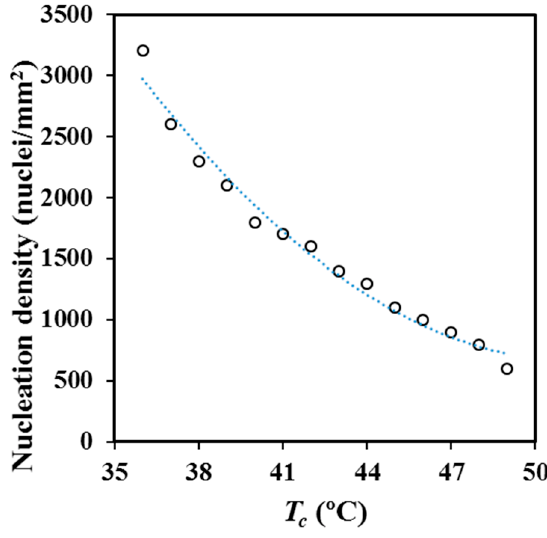
Figure 11. Temperature dependence of the primary nucleation density for crystallization performed from the melt state.